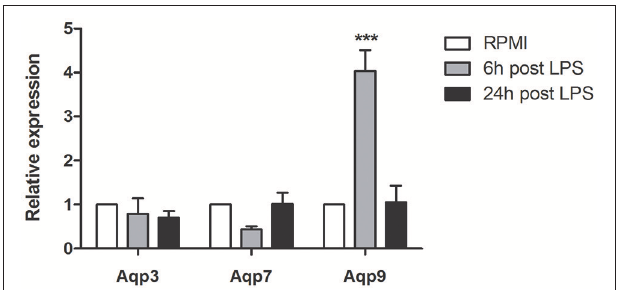
FIGURE 1 | Dendritic cells Aqps expression. The expression of Aqp 3, Aqp 7 and Aqp 9 was assessed at 6 and 24h after the stimulation with LPS (1 µ g/mL). Results are expressed as fold change compared to immature BMDCs. Bars represent the mean ± SEM of 3 independent experiments. *** P < 0.001.